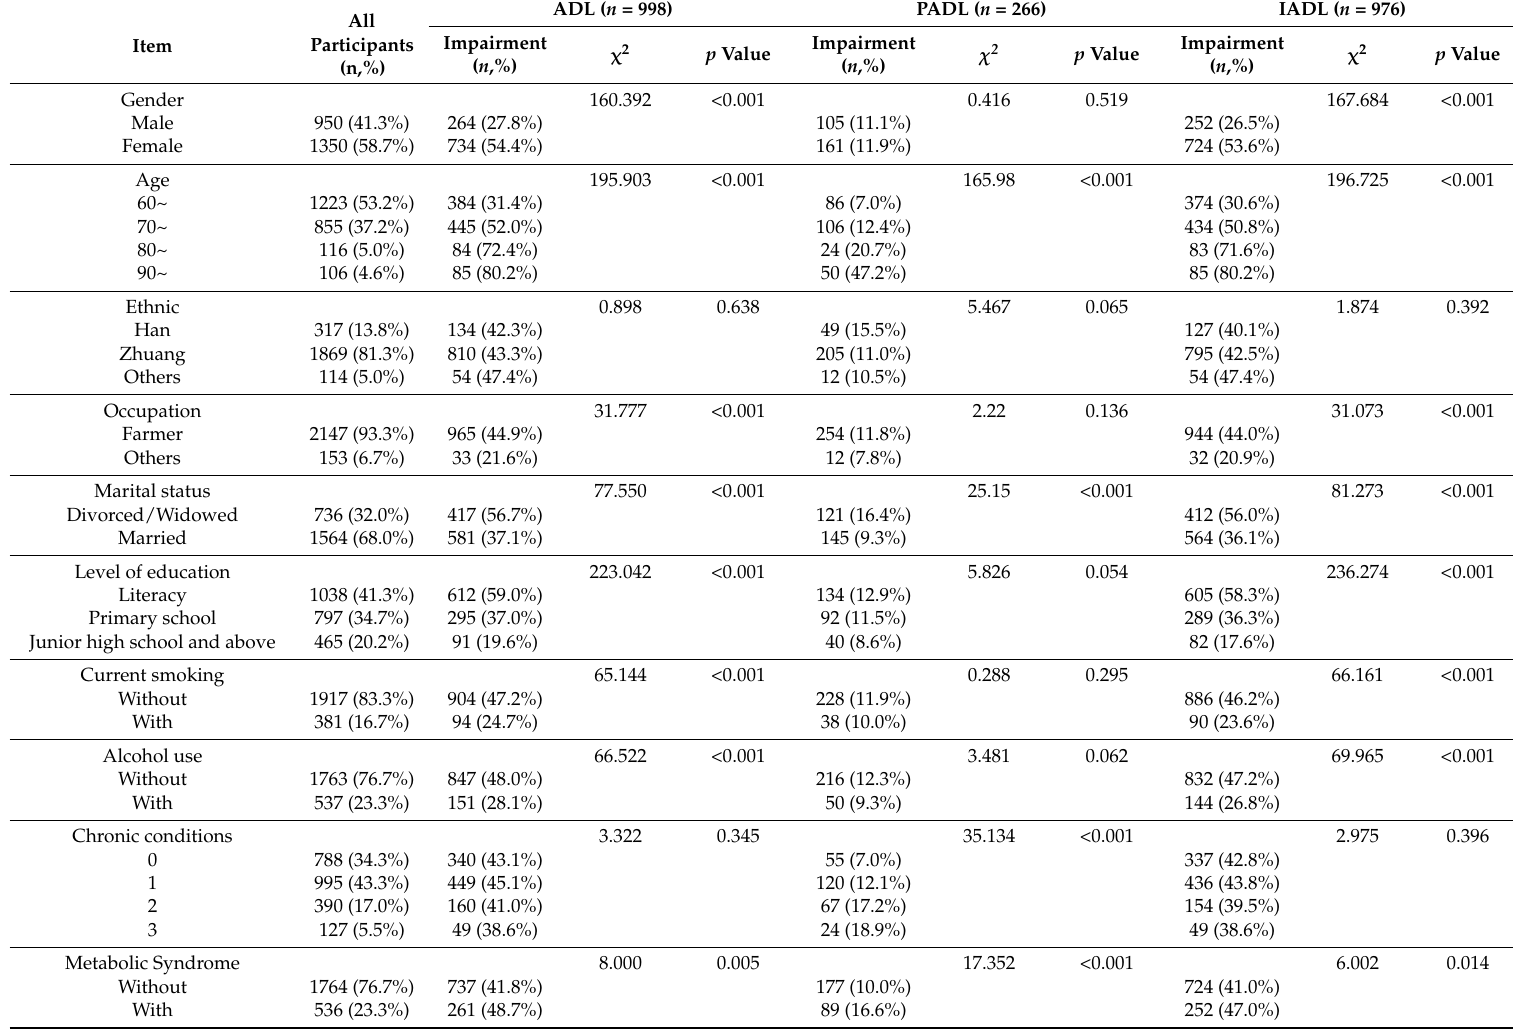
Table 1. Baseline characteristics of 2300 participants with and without incident ADL, PADL, and IADL